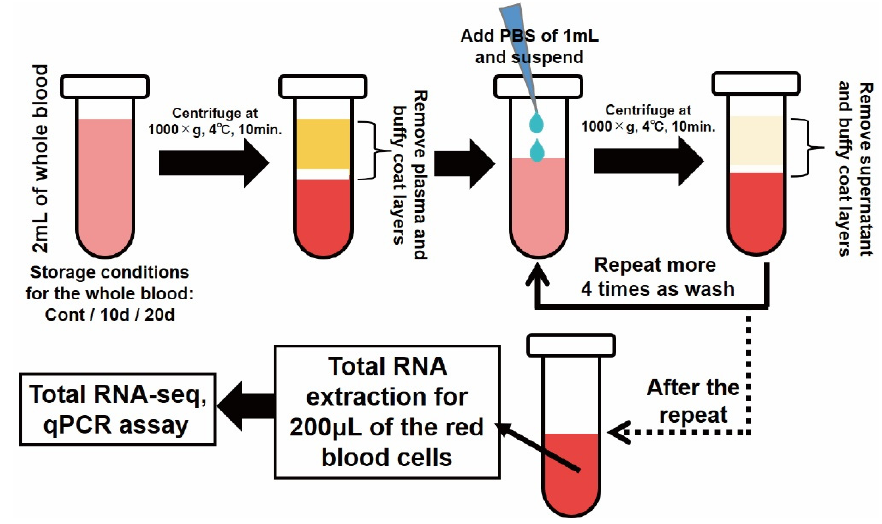
Figure 1. Purification method for RBCs in this